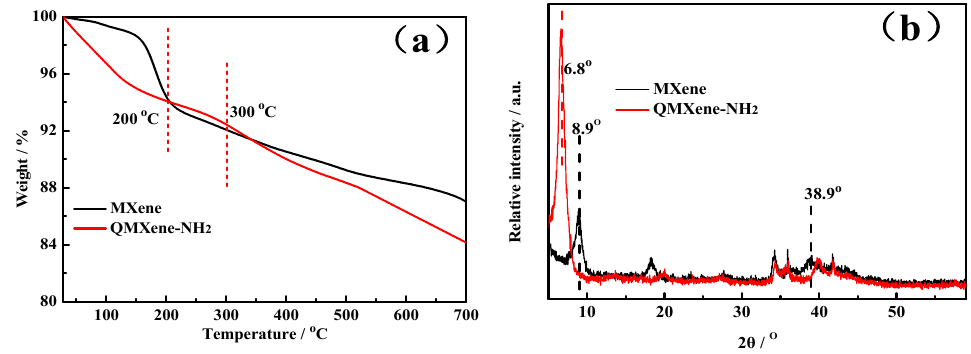
Figure 3. TGA ( a ) and XRD ( b ) curves of MXene and QMXene-NH 2 .